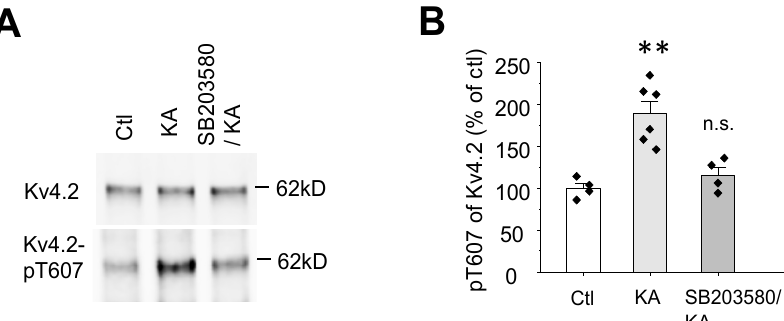
Figure 3. p38 MAPK contributes to kainic acid-induced Kv4.2 phosphorylation at T607. ( A ) SB 203580, a potent p38 inhibitor (20 mg/kg, i.p., 15 min), blocked kainic acid-induced phosphorylation of Kv4.2 T607 in mouse hippocampus. ( B ) Statistical analysis of the effect of SB 203580 on kainic acid-induced phosphorylation of Kv4.2 at Thr607 in mouse hippocampus, n = 4 – 6 in each group, t -test, ** p < 0.01.